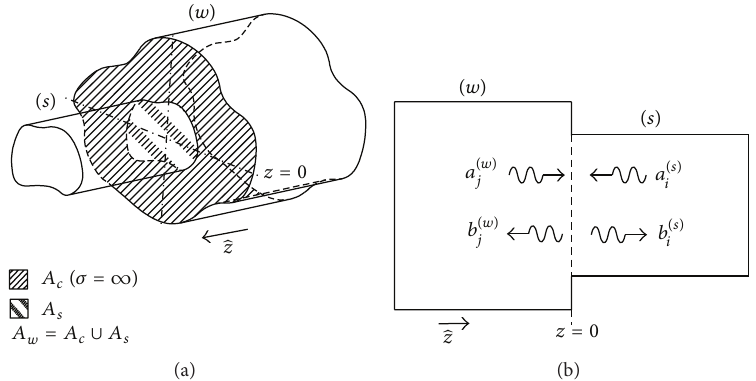
Figure 3: Generic waveguide step: (a) surface views and (b) modal